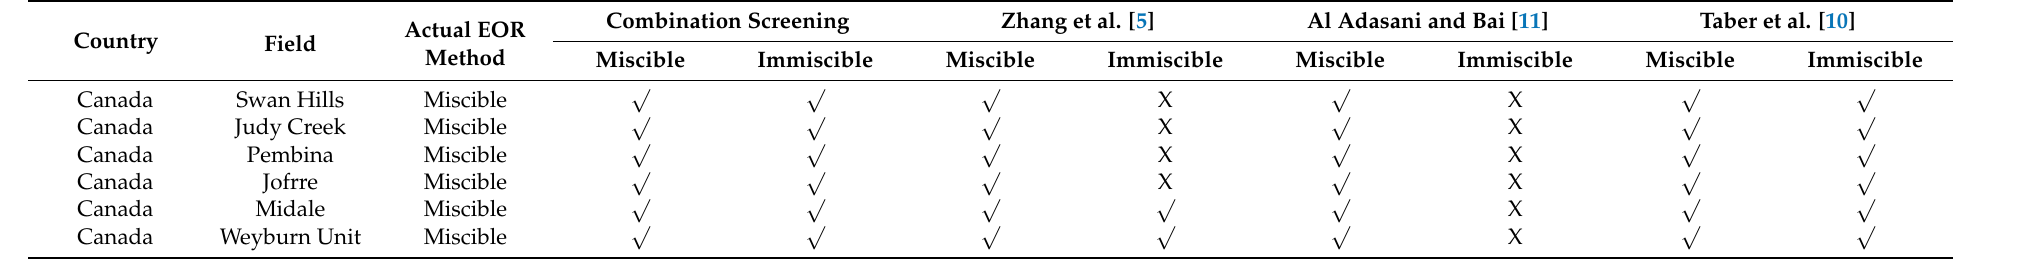
Table 6. Results of screening model implementation on miscible CO 2 -EOR fields.